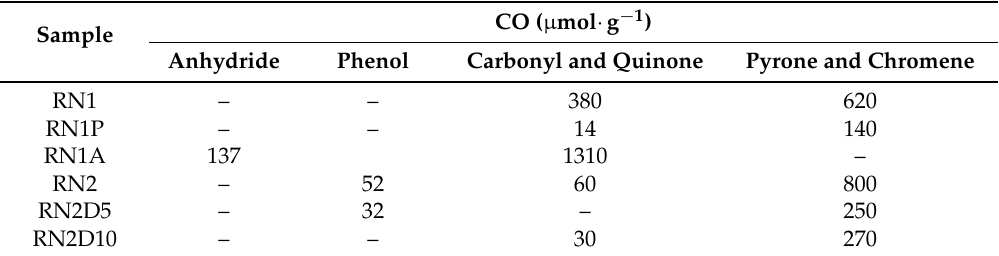
Table 4. Oxygen surface complexes distribution from CO TPD profiles.